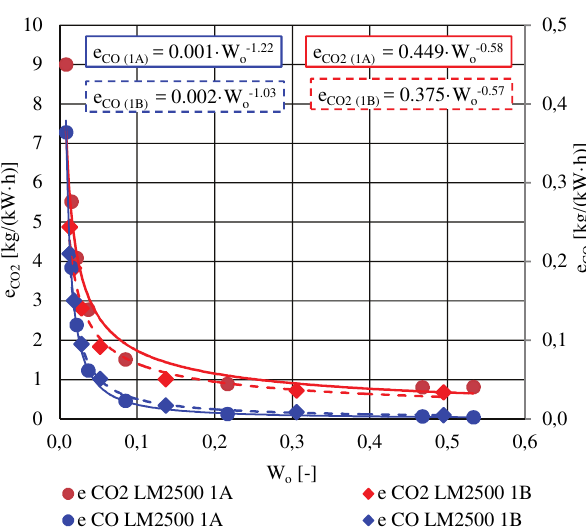
Fig. 11. The unit emission of carbon dioxide ( e